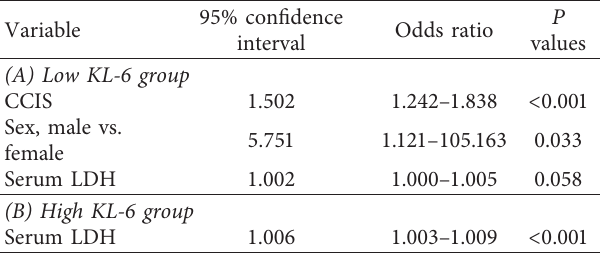
Figure 1: Comparison between high serum KL-6 and low serum KL-6 patients. The enrolled patients consist of 38 (40%) patients with high serum KL-6 (idiopathic: 28 patients and secondary: 10 patients) and 57 (60%) patients with low serum KL-6 (idiopathic: 34 patients and secondary 23 patients) levels. There is no significant difference in the 6-month prognosis between the high and low serum KL-6 patients ( P � 0.685) (a). In addition, high serum KL-6 patients with AEs of idiopathic or secondary ILDs and low serum KL-6 patients with AEs of idiopathic or secondary ILDs have similar 6-month outcomes ( P � 0.950) (b). ILD: interstitial lung disease; KL-6: Krebs von den Lungen-6. Table 2: Multiple stepwise regression analysis of primary pre- dictors of 6-month mortality (age, sex, CCIS, diagnosis, LDH, P/F ratio, ground-glass opacity, and honeycomb